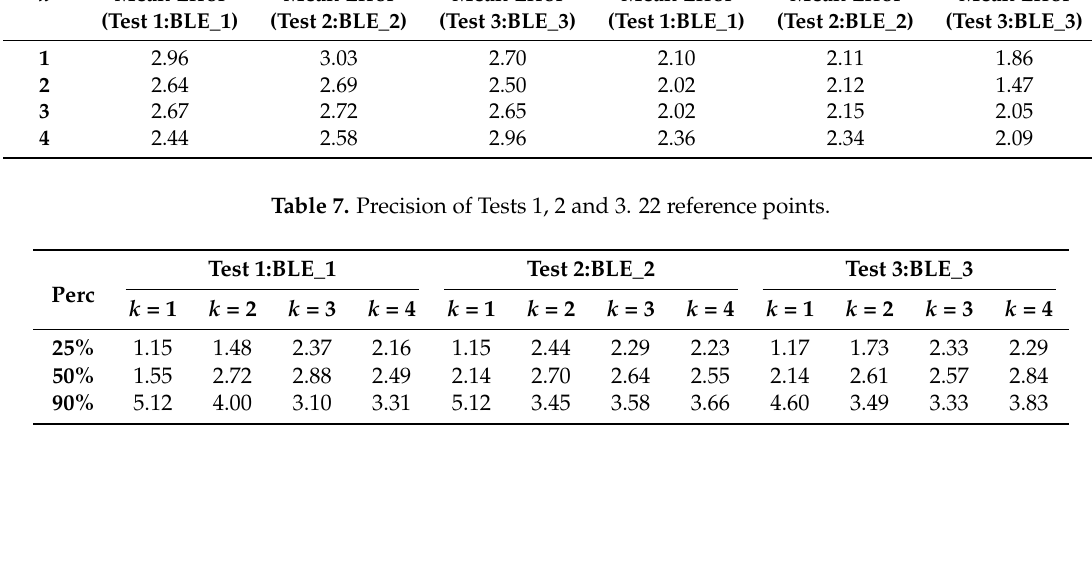
Table 6. Accuracy of Tests 1, 2 and 3: mean errors for different k -values. 22 Reference Points 42 Reference Points